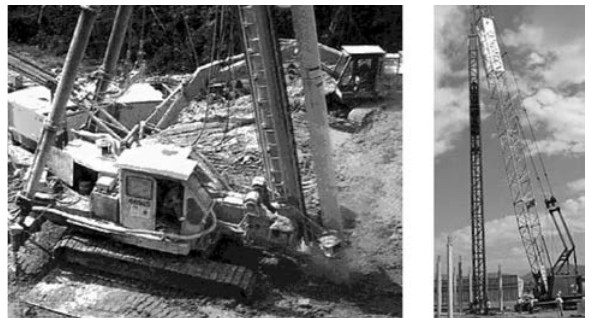
Fig. 4. Inserting circular steel casing into ground by hydraulic hammer mounted on crawler crane